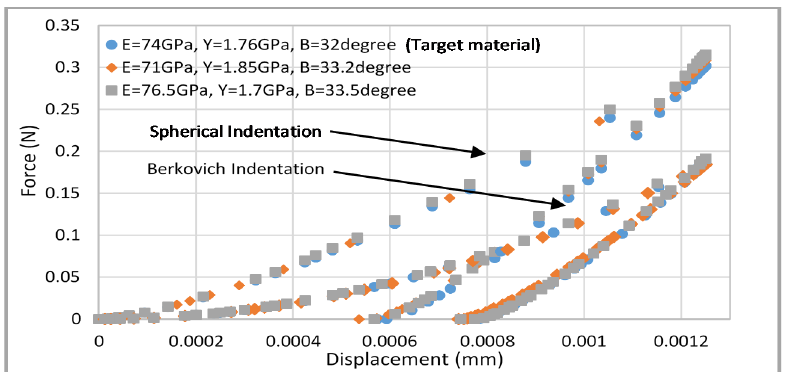
Figure 14. Comparison of load displacement curves between the predicted and target pressure-sensitive plastic material properties using the S&B approach.